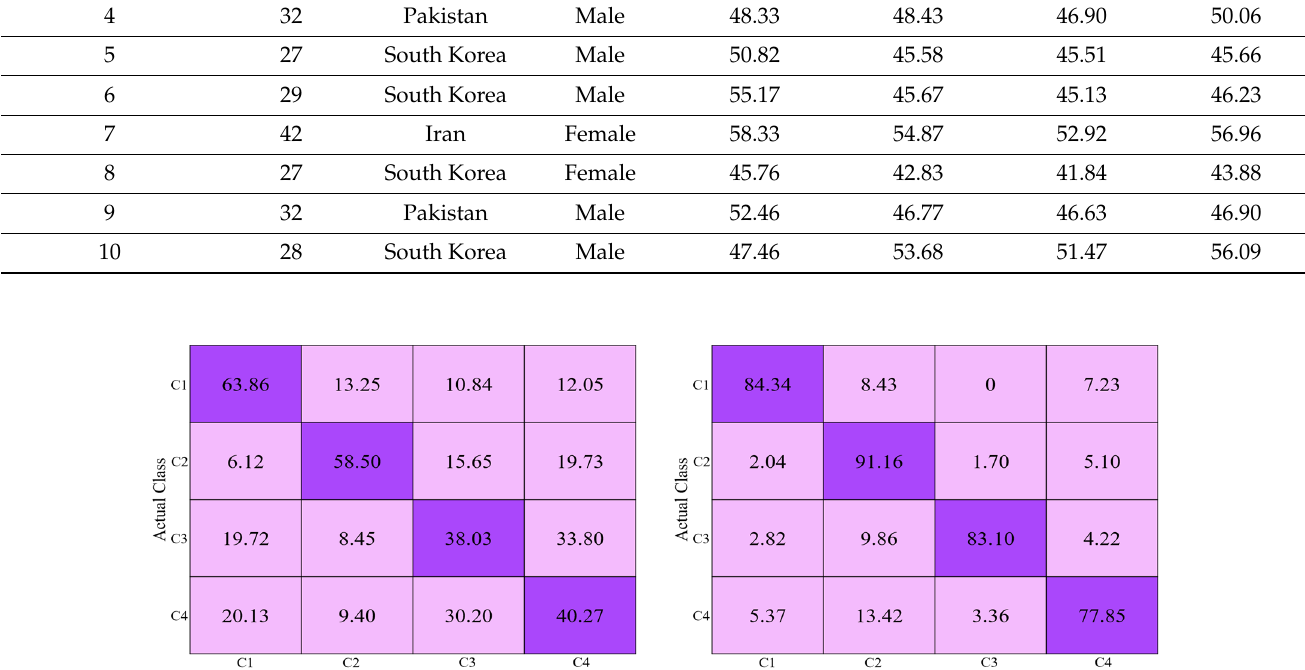
Figure 12. Performance comparison in terms of confusion matrices of ( a ) subjective method and ( b ) the proposed DRE-Net (sequential training). C1–C4 indicate the classes of four manufacturers of Cofield, Depuy, Tornier, and Zimmer, respectively (unit: %).